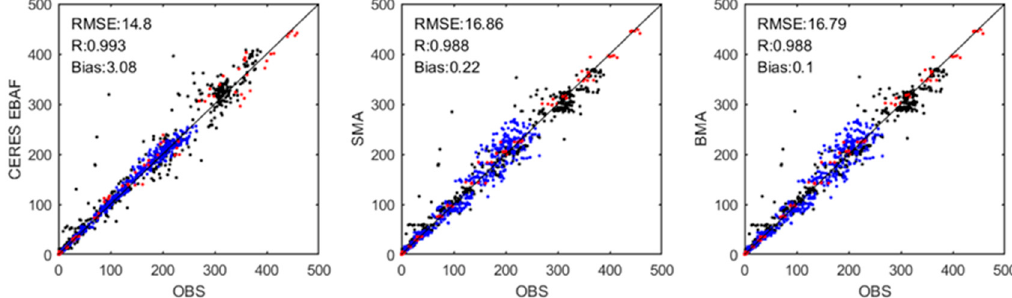
Figure 6. Evaluation of monthly SSR estimated from the Clouds and the Earth’s Radiant Energy System, Energy Balanced and Filled (CERES EBAF), simple model averaging (SMA) method, and BMA method from 2000 to 2005 (in units of W m -2 ).